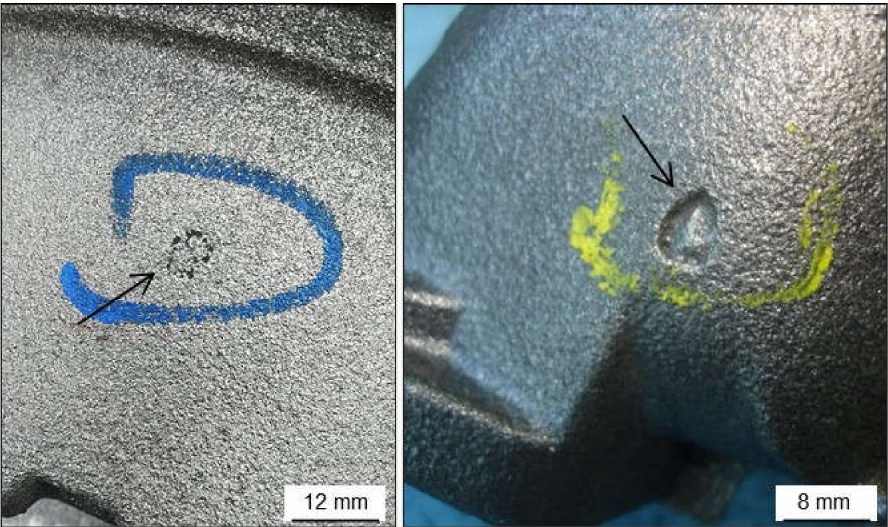
Figure 52. Fish-eye defects present in iron castings surfaces.